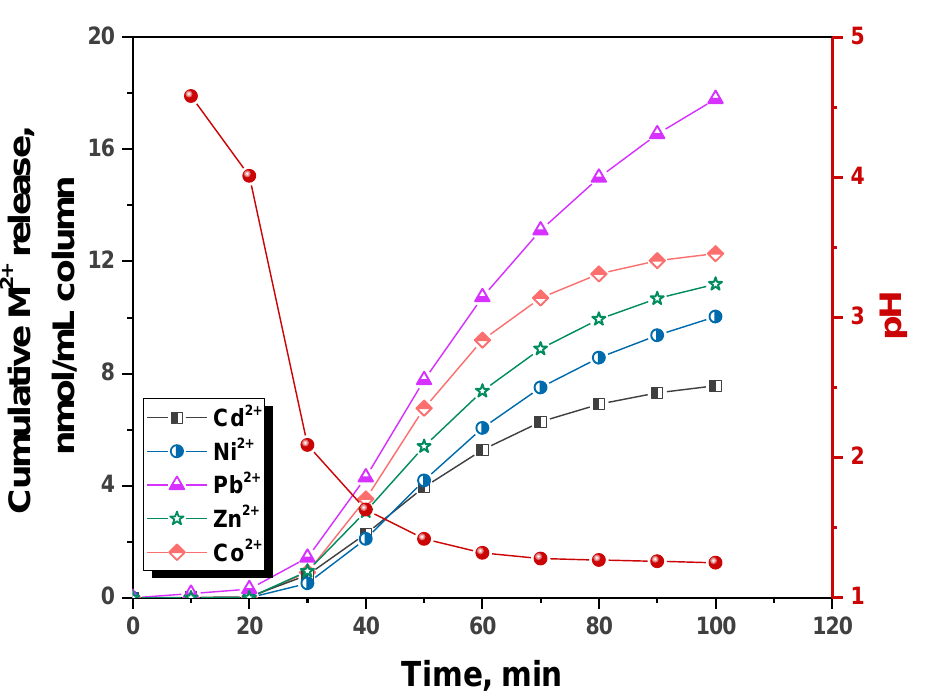
Figure 6. Cumulative M 2+ release (nmol/mL column) in dynamic conditions and effluent pH during desorption of HMIs with 0.1M HCl from the CS EDTA -CPL microbeads.